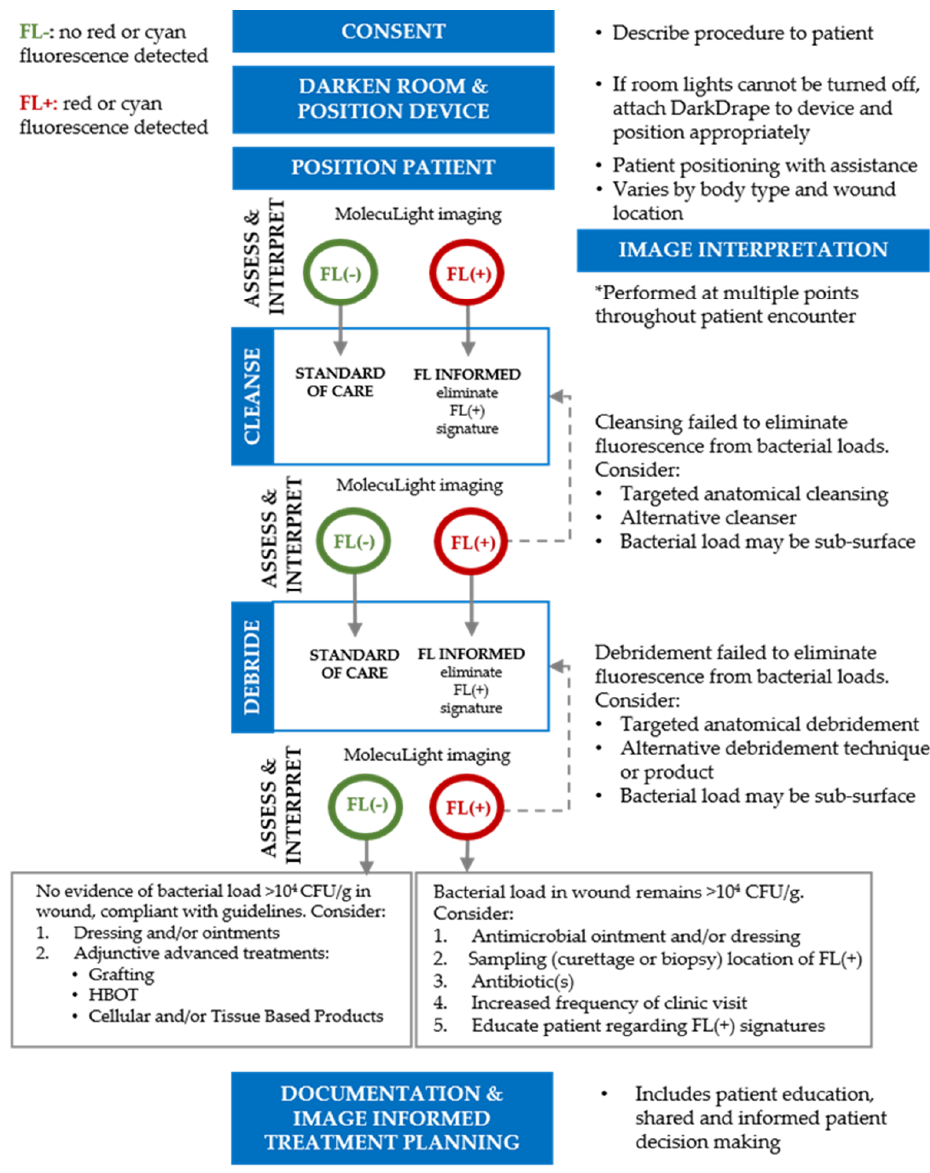
Figure 2. Clinical workflow for point-of-care fluorescence imaging. This clinical workflow describes the typical processes performed by clinicians when incorporating fluorescence imaging into their care pathway. This iterative approach provides clinicians with evidence of bacterial burden at the point-of-care and emphasizes use of clinical judgement to select actions that target removal of bacterial burden from the wound to facilitate wound healing. FL, fluorescence imaging; HBOT, hyperbaric oxygen therapy. Table 3. Wound types where fluorescence imaging of bacterial burden may be indicated. Fluorescence Imaging May Be Performed on (but Not Limited to) Any of the